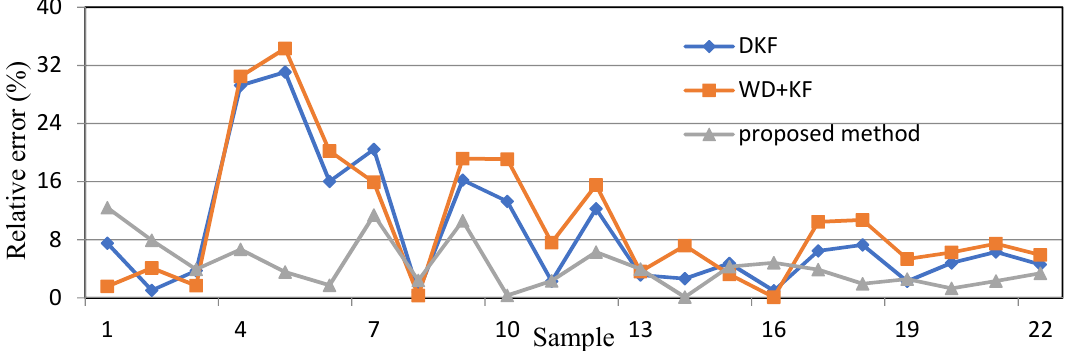
Figure 20. Prediction errors from the different methods based on hourly data.